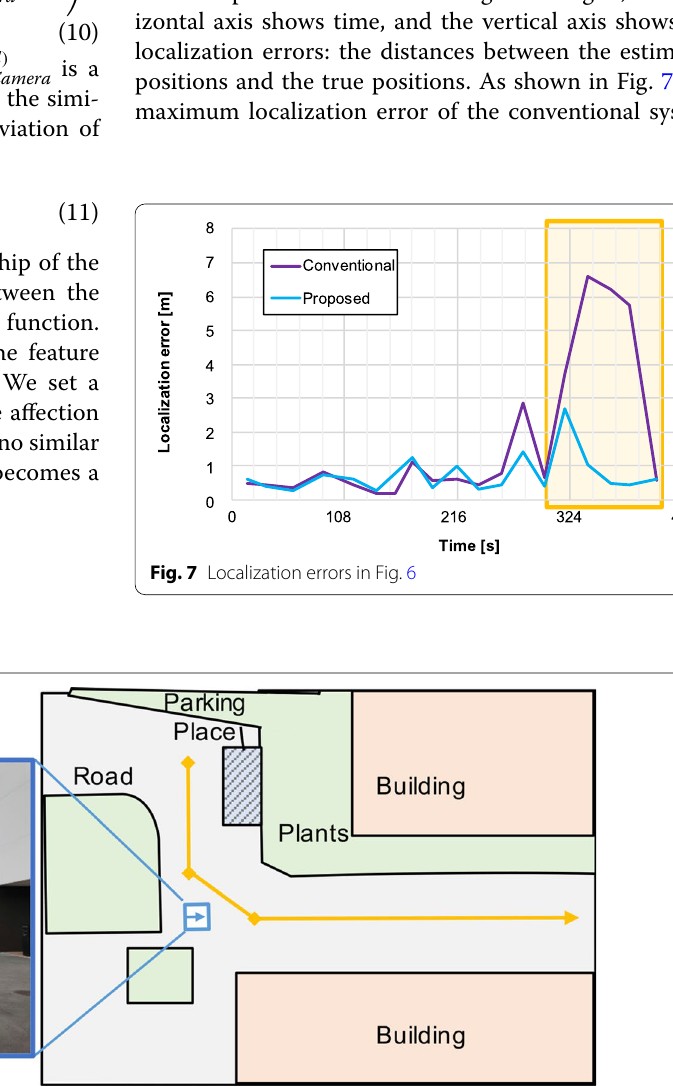
Fig. 6 Experimental environment (road between buildings)